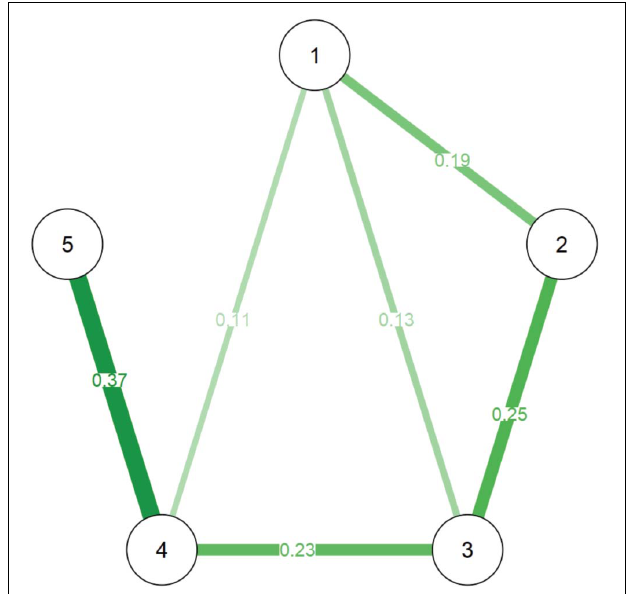
FIGURE 1 | The edges represent regularized partial correlations. Green lines show positive associations. Red lines would have indicated negative ones (none observed). The nodes indicate the variables as it follows: (1) Text Comprehension, (2) Reading fluency, (3) Reading accuracy, (4) Syntactic comprehension, and (5) Non-verbal